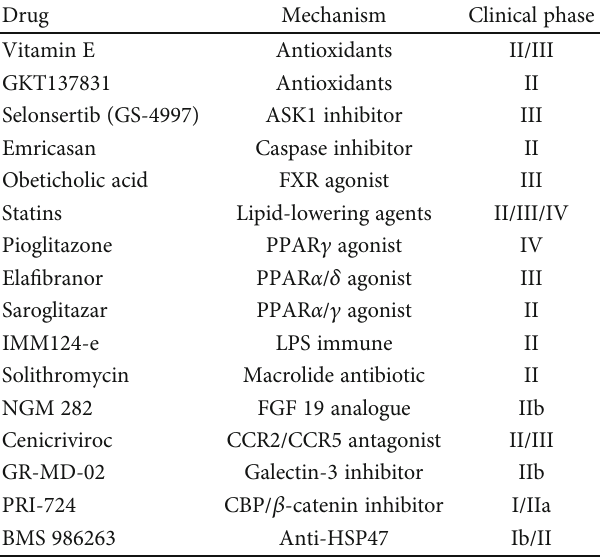
Table 1: Potential anti fi brotic drugs for hepatic fi